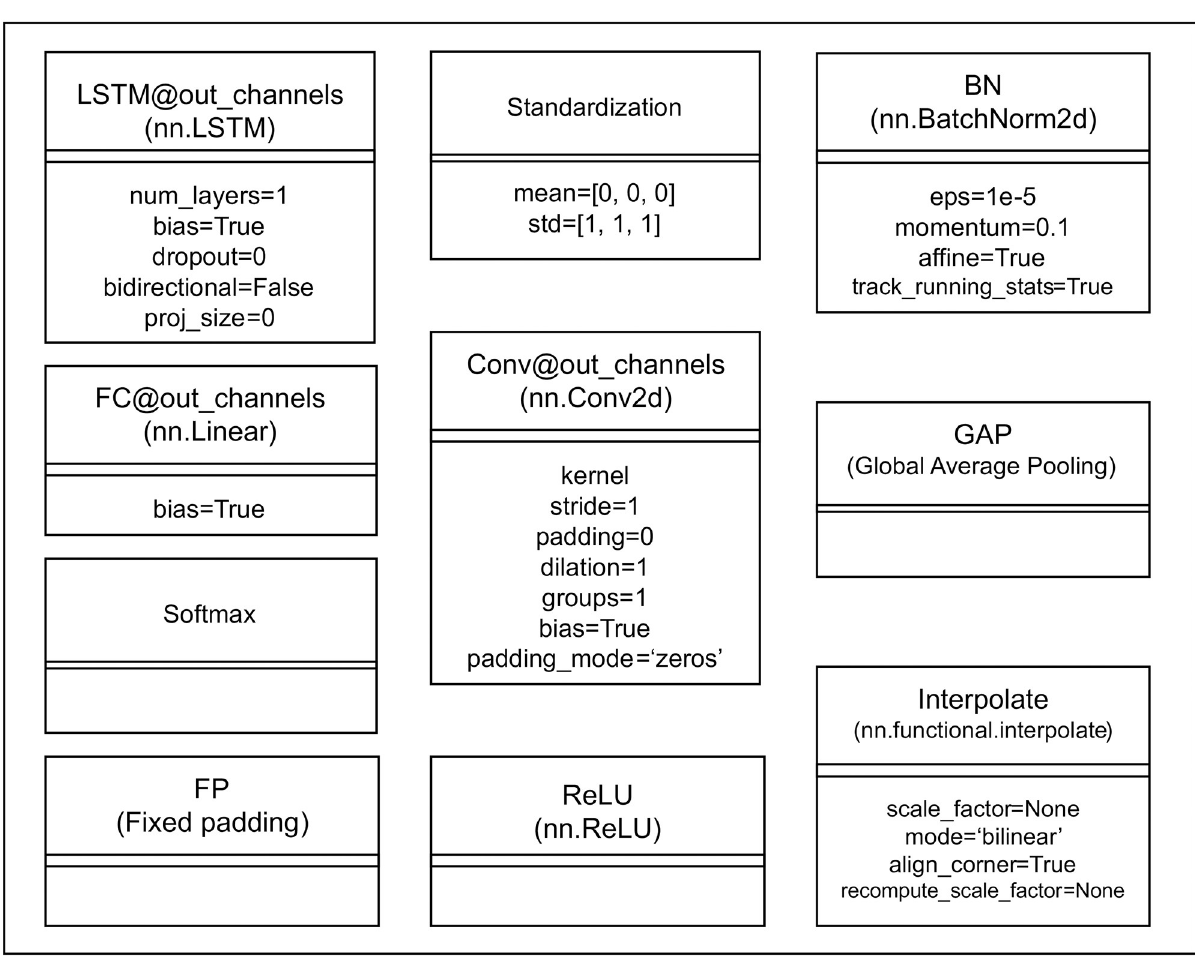
Fig 3. Class diagram of the layers used in the model diagrams in Figs 2 and 4. This figure describes the hyper-parameters that can be set for each class and their default